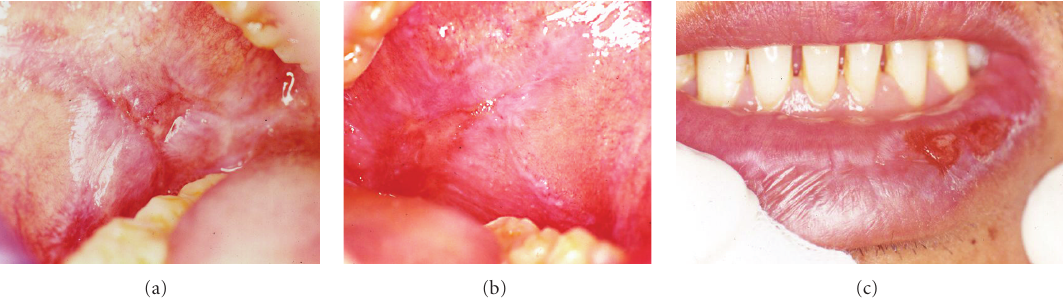
Figure 2: The oral lesions at the first visit: (a) right buccal mucosa, score 5, (b) left buccal mucosa, score 5, and (c) lip, score 4. Note the white striae and papules with deep ulceration on the erythematous